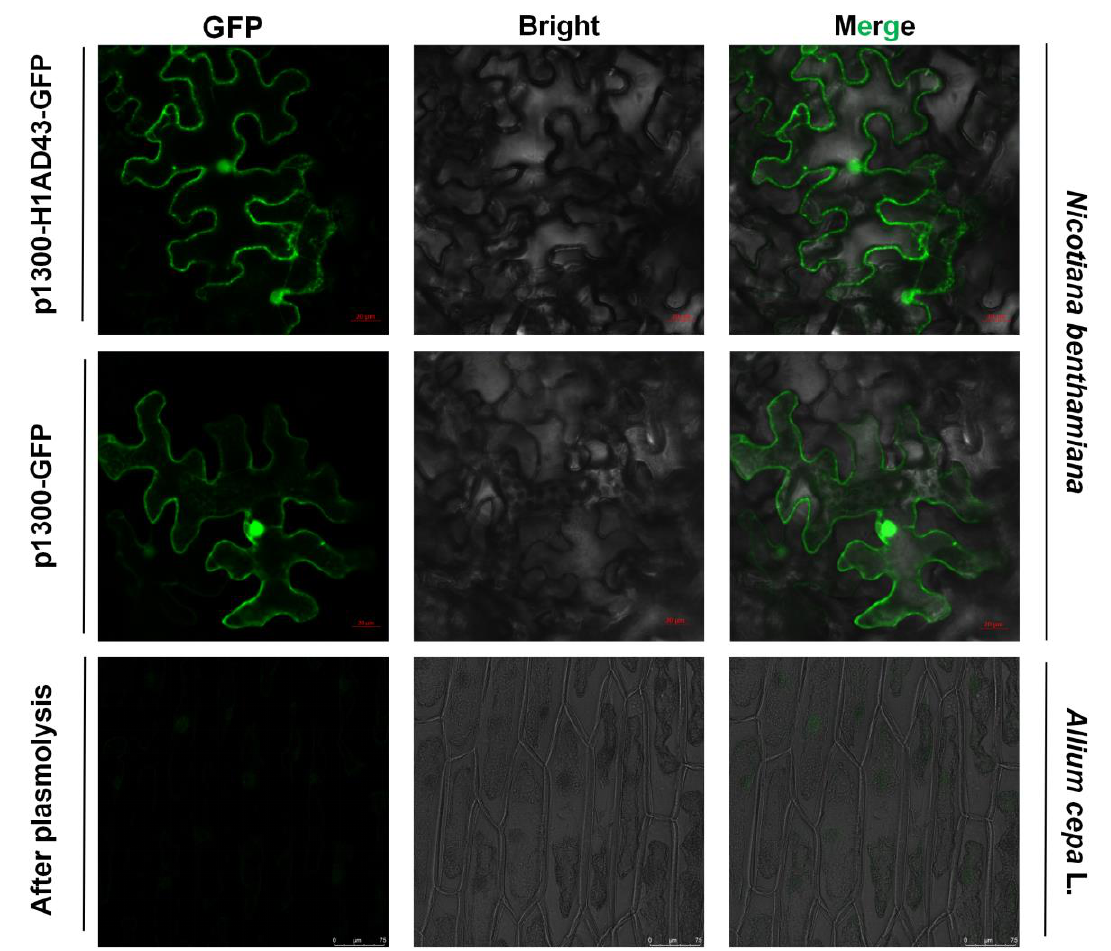
Figure 4. Localization analysis of H1AD43 in N. benthamiana and onion epidermal